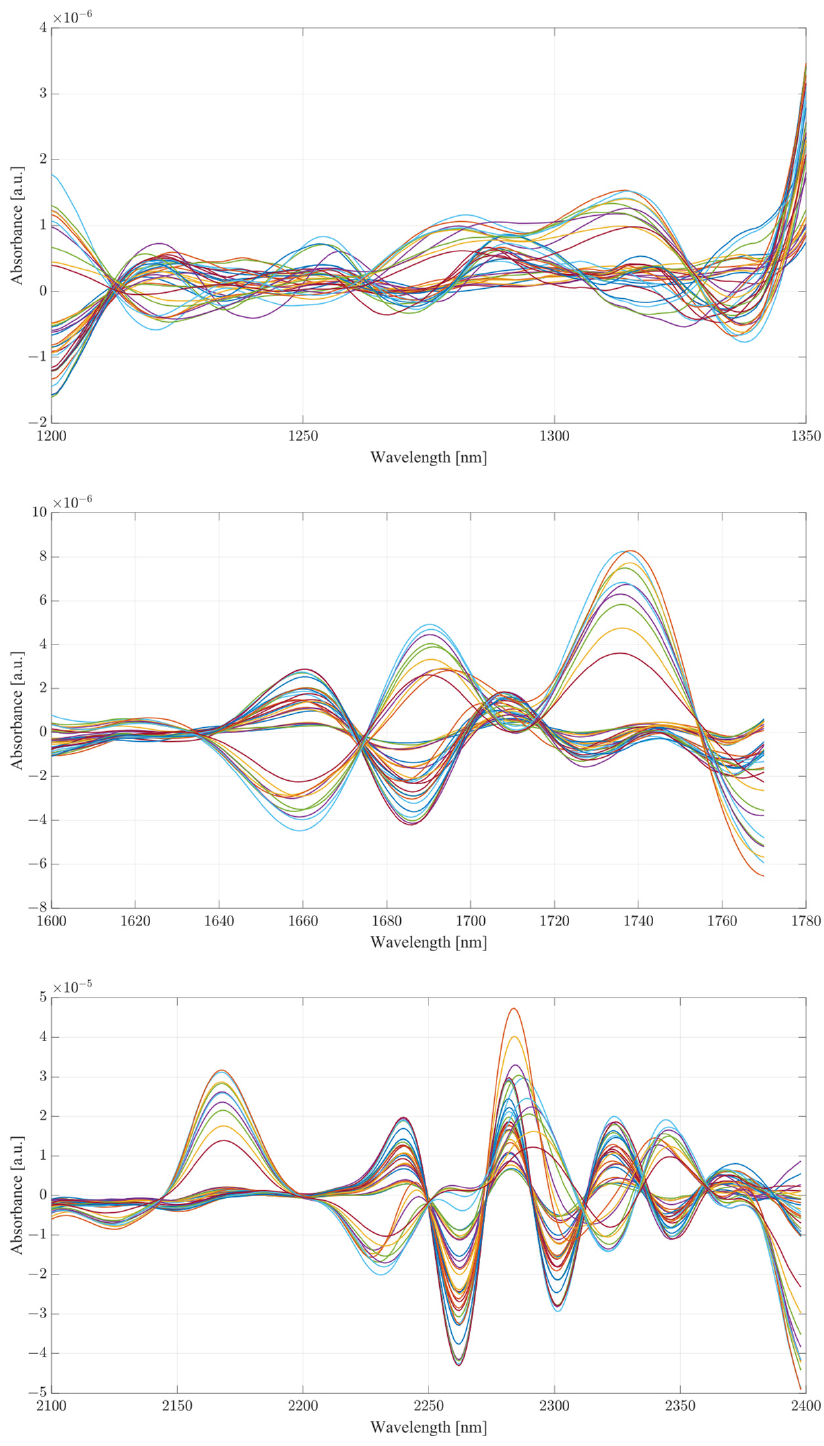
Figure 5. Serum mixture results, from top to bottom: raw spectra, postbaseline subtraction, second derivative, therapeutic window II, therapeutic window III, therapeutic window IV.